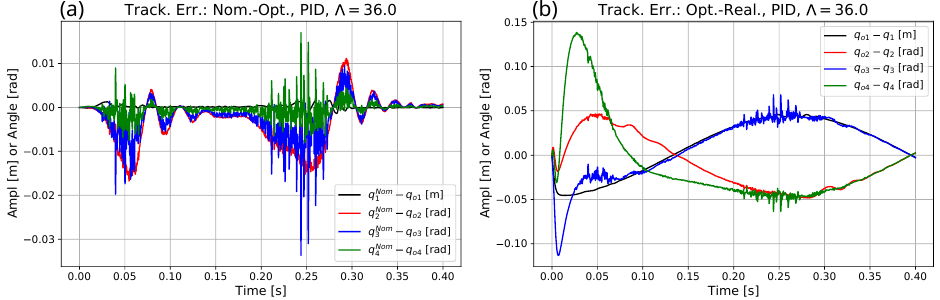
Figure 16. Trajectory tracking without force limitation for the increased α min = 0.1. ( a ) For q 1 and q 2 . ( b ) For q 3 and q 4 .